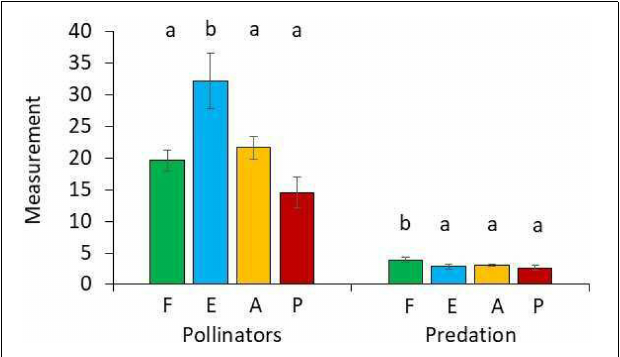
FIGURE 2 | Average numbers of pollinators (all color traps combined) and bite marks (arthropod predation) in the forest (F, green), the forest edge (E, blue), the agricultural fields (A, orange), and the tree plantation (P, red). Different letters above the bars denote statistically significant differences in pair-wise U-tests after one-way Kruskal–Wallis ANOVA at P < 0.05. Error bars denote standard errors.